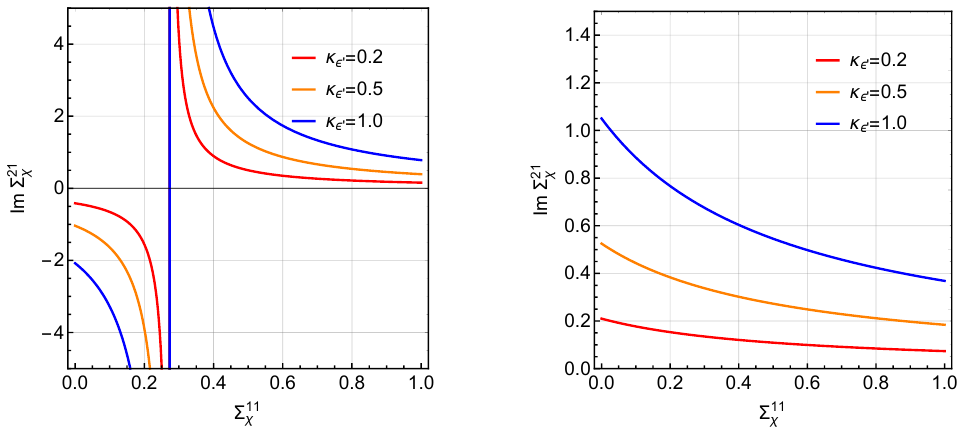
Figure 3. The dependence of the Im(cid:6) 21 for di(cid:11)erent values of (cid:20) " 0 and M LQ = 20 TeV.